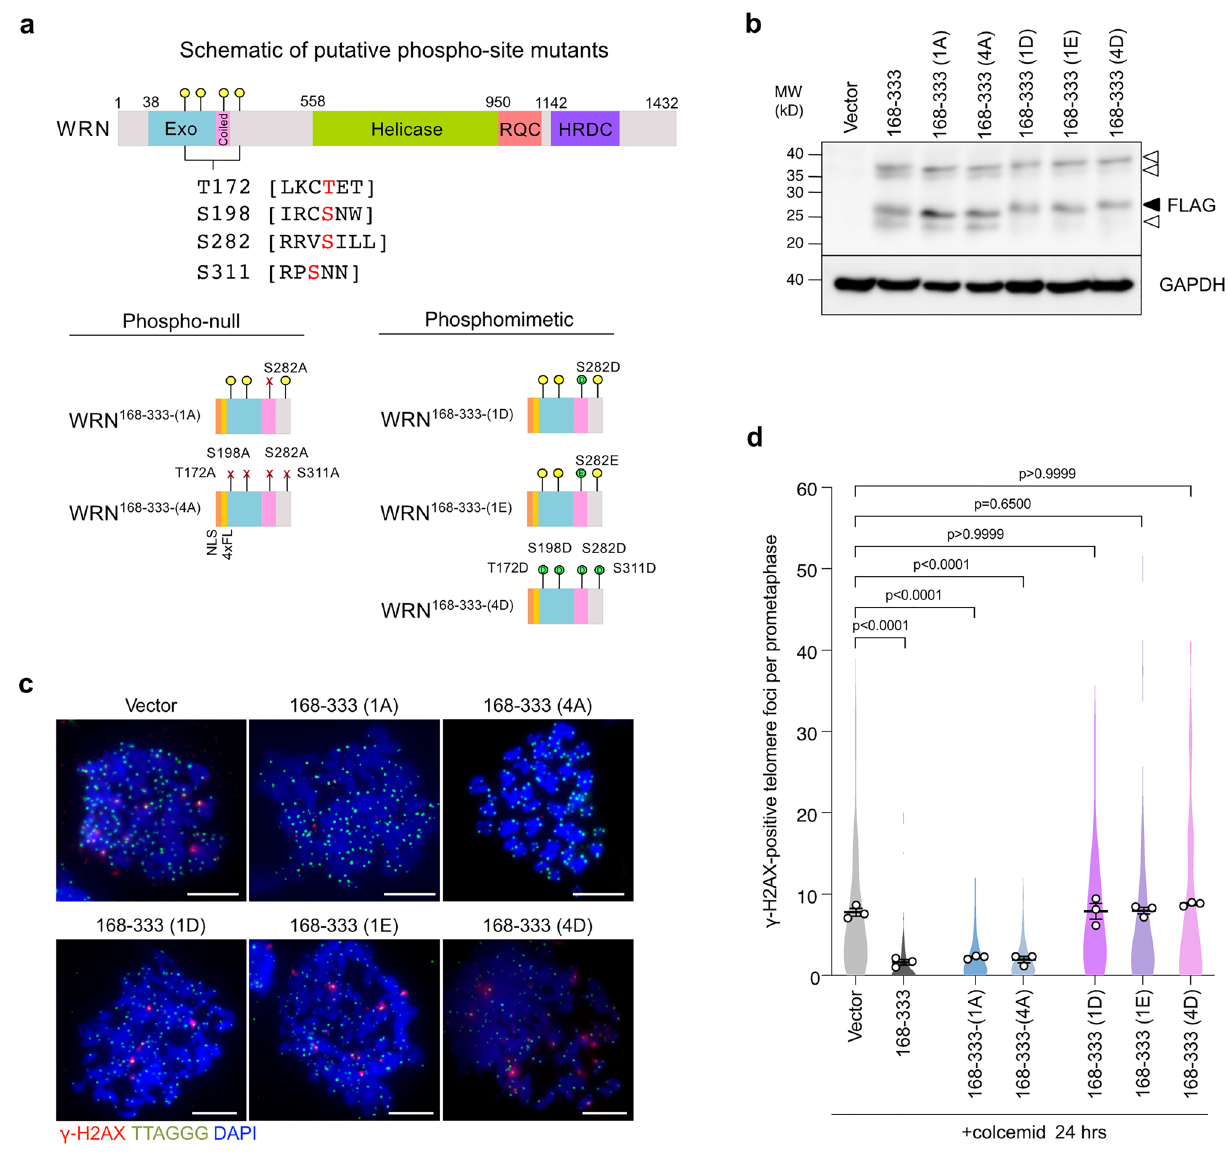
Figure 5. Phosphomimetic mutation at S282 of WRN 168–333 disrupts its MAD-TIF suppressor effect. ( a ) Schematic representation of four potential Aurora B sites in the 168–333 aa of WRN N-terminus. Sites of alanine and phosphomimetic mutations are indicated below. All mutants contain N-terminal NLS and 4xFLAG tags. ( b ) Immunoblot of FLAG-WRN fragments in indicated cells. Transduced cells were harvested on day 12 post-infection. A black arrowhead indicates the expected band size for all the mutants (~ 27 kDa), and white arrowheads indicate additional bands. ( c ) Representative images of meta-TIF assay in indicated cells after treatment with 100 ng/ml colcemid for 24 h. The images show DAPI (blue), γ-H2AX (red), and telomere FISH (green). Scale bar, 10 µm. ( d ) Quantification of telomeric signals colocalized with γ-H2AX foci in indicated conditions as shown in Fig. 1c (n = 30/experiment; mean ± s.e.m.; Kruskal–Wallis followed by Dunn’s test). Unprocessed blot images are shown in Supplementary Information